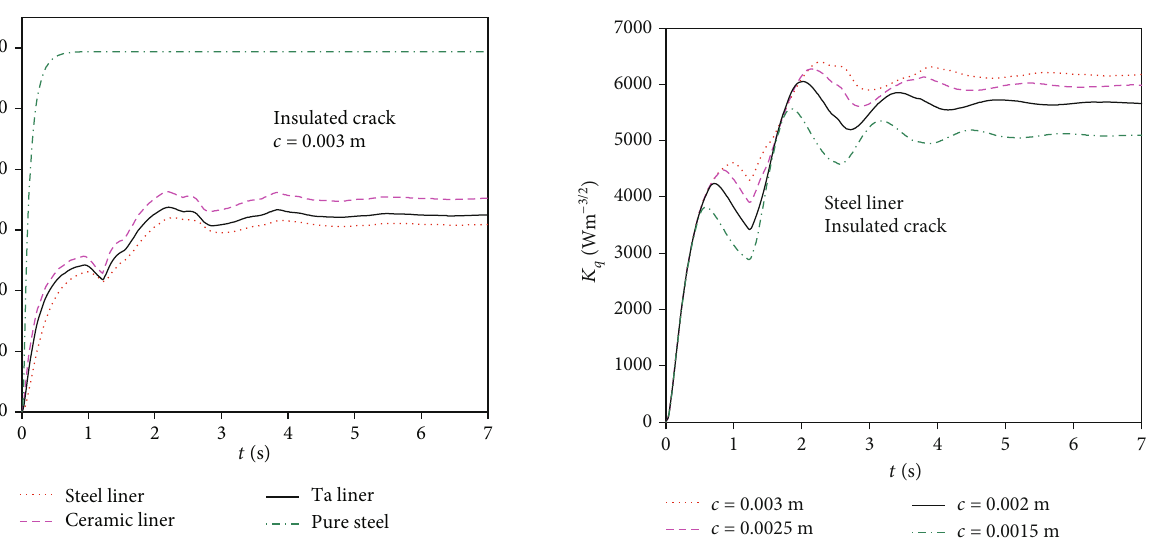
Figure 8: E ff ect of crack length on the HFIF history.